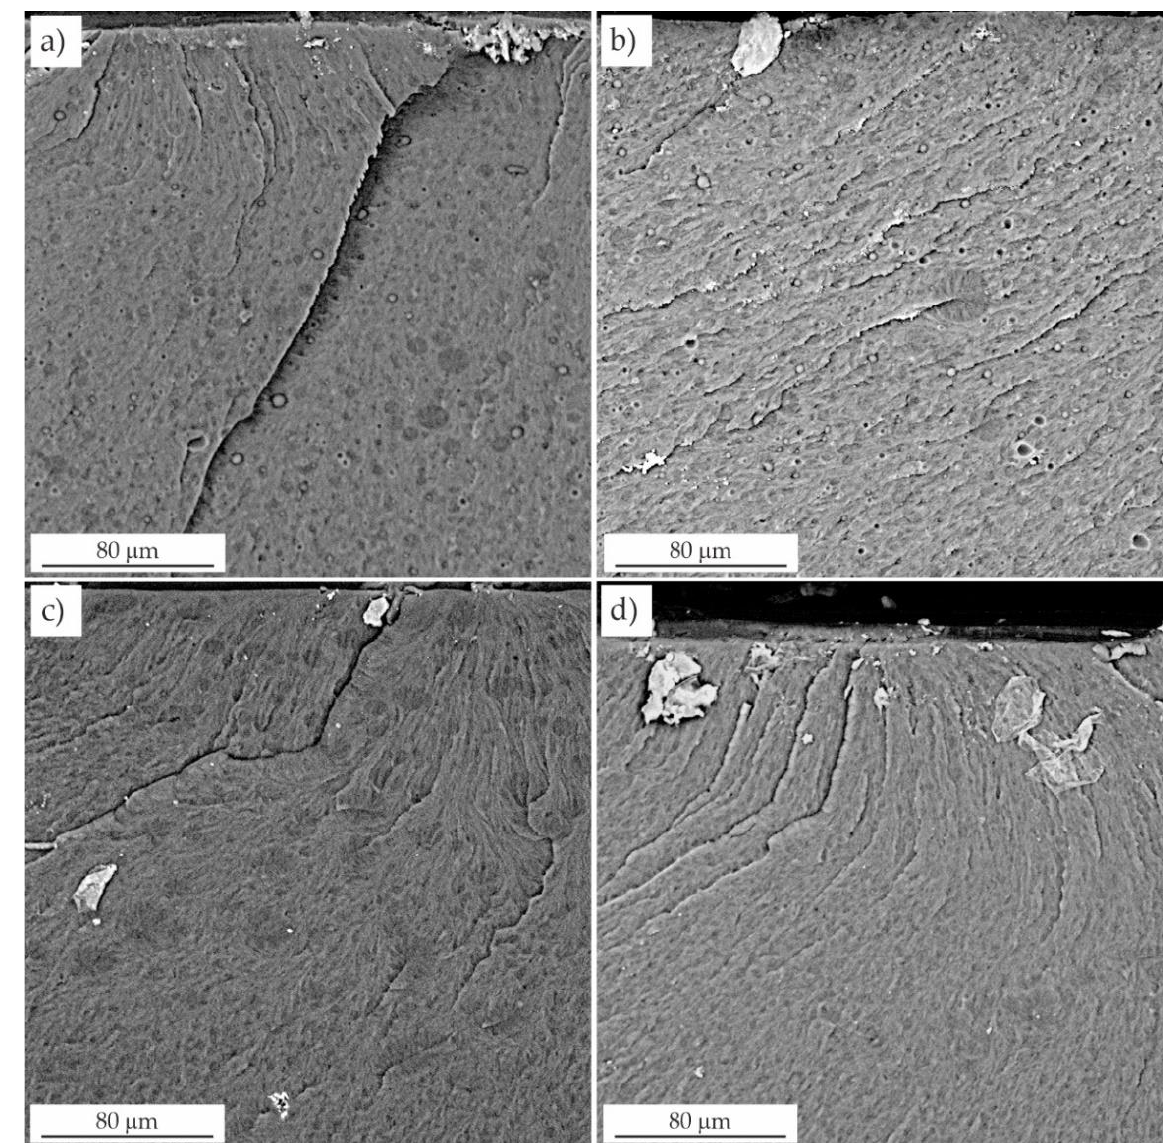
Figure 9. Fractures of resins modified with liquid rubber. ( a ) resin F + 15 wt.% LR, ( b ) resin C + 15 wt.% LR, ( c ) resin F + 20 wt.% LR, ( d ) resin C + 20 wt.% LR.